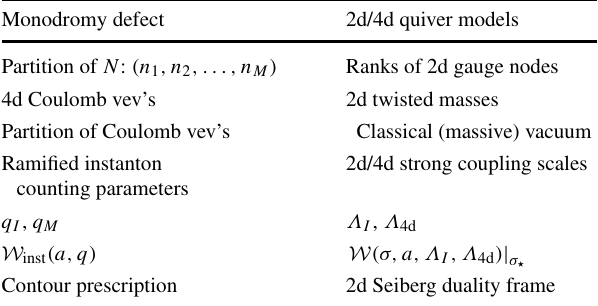
Table 7 The dictionary between the various features of surface oper- ators in the two descriptions, as monodromy defects and as coupled 2d/4d